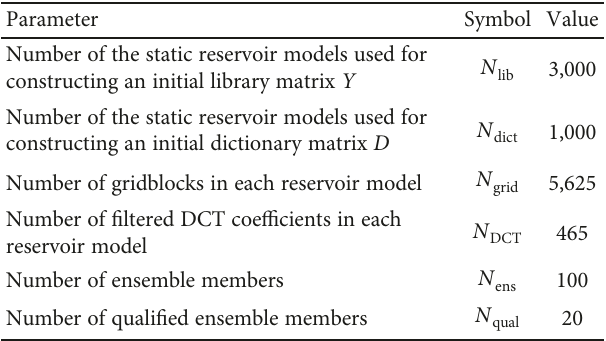
Table 4: Number of parameters used for the ten ES-MDA algorithms.